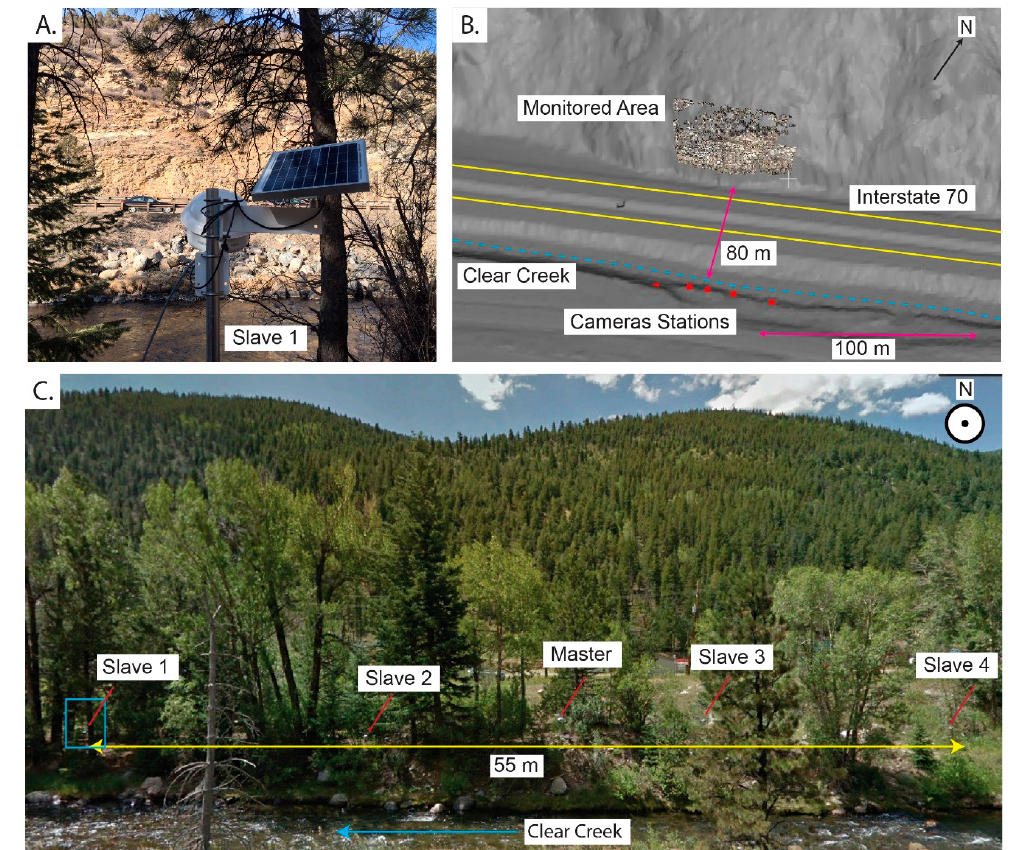
Figure 4. ( A ) Example of camera housing and solar panel installed on site overlooking monitored slope. ( B ) Digital Elevation Model of site showing camera locations, area of interest, Interstate 70, and clear creek. ( C ) Position of five camera stations on opposing side of Clear Creek.